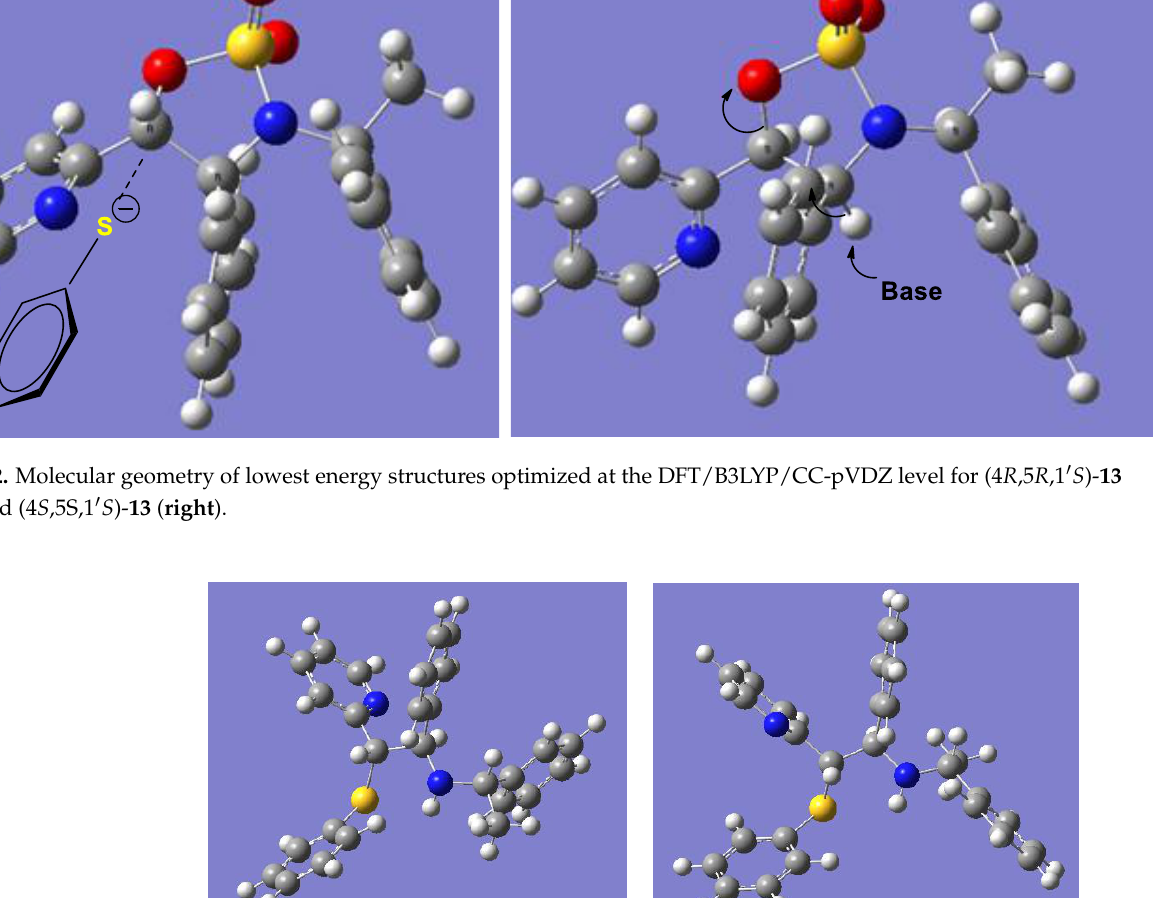
Scheme 2. Syntheses of S and Se compounds via nucleophilic substitution of sulfonamidates. Figure 3. Molecular geometry of lowest energy structures optimized at the DFT/B3LYP/CC-pVDZ level for. (1 R ,2 S ,1′ S )- 16 (left) and (1 S ,2 R ,1′ S )- 16 (right).